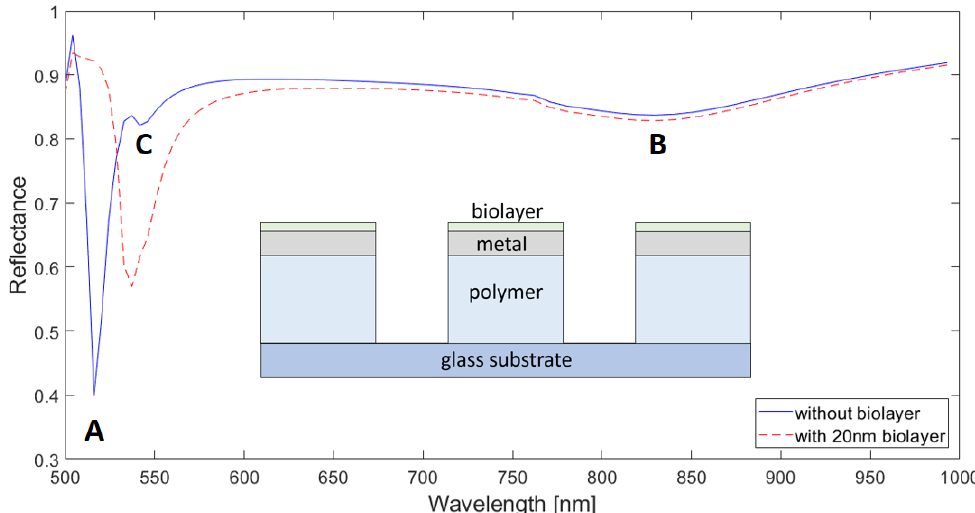
( d ) Figure 3. Cross-sectional electric field distributions of the studied configuration for d = 150 nm and h = 150 nm. ( a ) E x at resonance (  = 516 nm), ( b ) E x out-of-resonance (  = 600 nm), ( c ) E z at resonance (  = 516 nm), ( d ) E z out-of-resonance (  = 600 nm). Equation (1) also predicts an SPP resonance for i = ±1, j = ±1 at the metal/polymer interface at 553 nm for the no-biolayer case, but no reflectance dip that could be associated with it is observed in Figure 2. To gain insight into this issue, we calculated the response of the original configuration (Figure 1) without the bottom Al disks (hereafter, no-disk configuration); this is plotted in Figure 4. In addition to the two dips displayed by the original structure (A and B), the no-disk configuration exhibits a reflectance minimum (C) at  C  = 545 nm, which agrees well with the aforementioned (±1, ±1) metal/polymer SPP resonance. This suggests that the Al disks are responsible for the suppression of the (±1, ±1) metal/polymer SPP resonance in the original configuration. We attribute this effect to the overlap of the corresponding optical field with the lossy Al disk. This is corroborated by Figure 5a,b that plot the E z -field distributions of the original structure and no-disk configuration, respectively, at